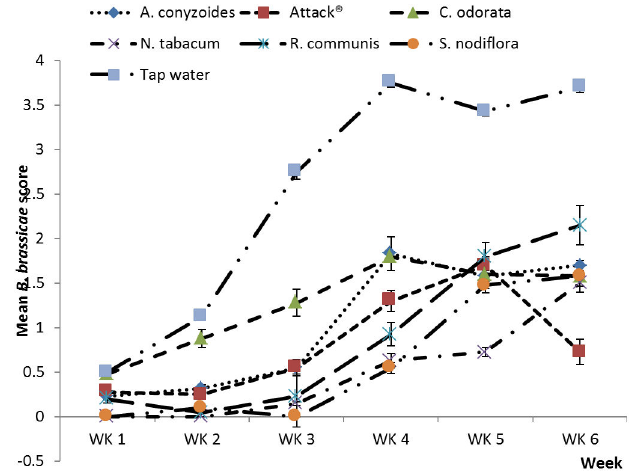
Figure 3. Plant extracts on B. brassicae , major season. Effects of plant extracts and synthetic insecticide on mean (±SE) Brevicoryne brassicae score in a field experiment during the major rainy season, 2012 at Kumasi, Ghana. doi: